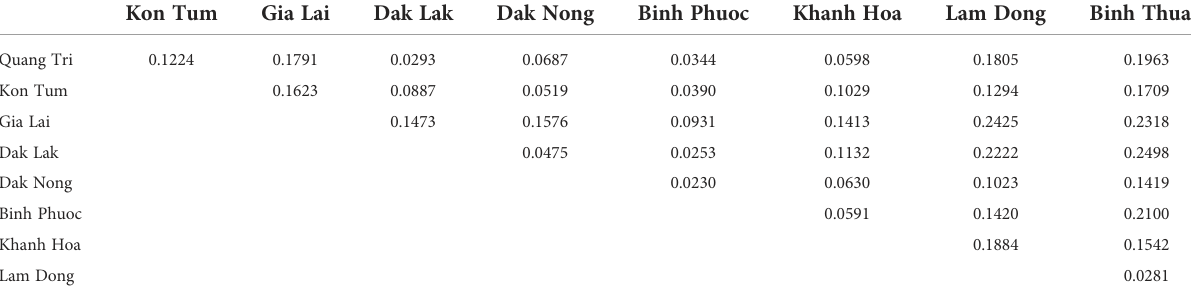
TABLE 5 Genetic differentiation among P. vivax population in different provinces in Vietnam.